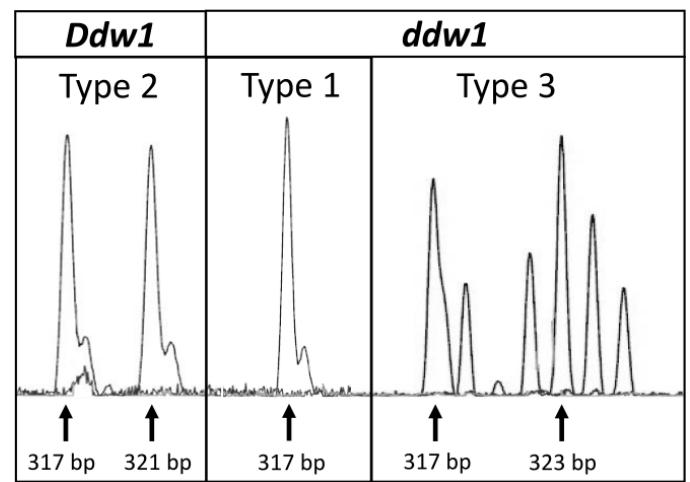
Figure 1. Capillary electrophoresis profiles of PCR amplification products for REMS1218 marker. DNA from homozygote Ddw1 and ddw1 triticale cultivars was used for PCR amplification. Amplification for Ddw1 Ddw1 plants results in PCR products pattern Type 2, 317 bp + 321 bp. Amplification for ddw1 ddw1 plants results in the PCR products patterns Type 1, 317 bp + 317 bp, and Type 3, 317 bp + 323 bp.